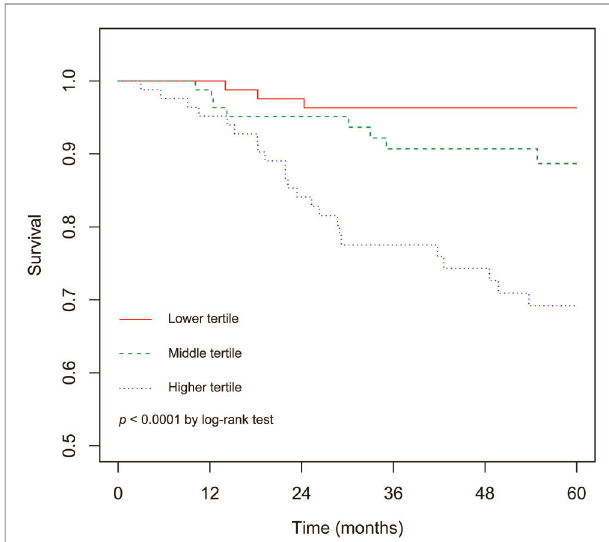
FIGURE 3 | The Kaplan-Meier curves demonstrating survival of hips following non-vascularized bone grafting according to tertiles of predicted